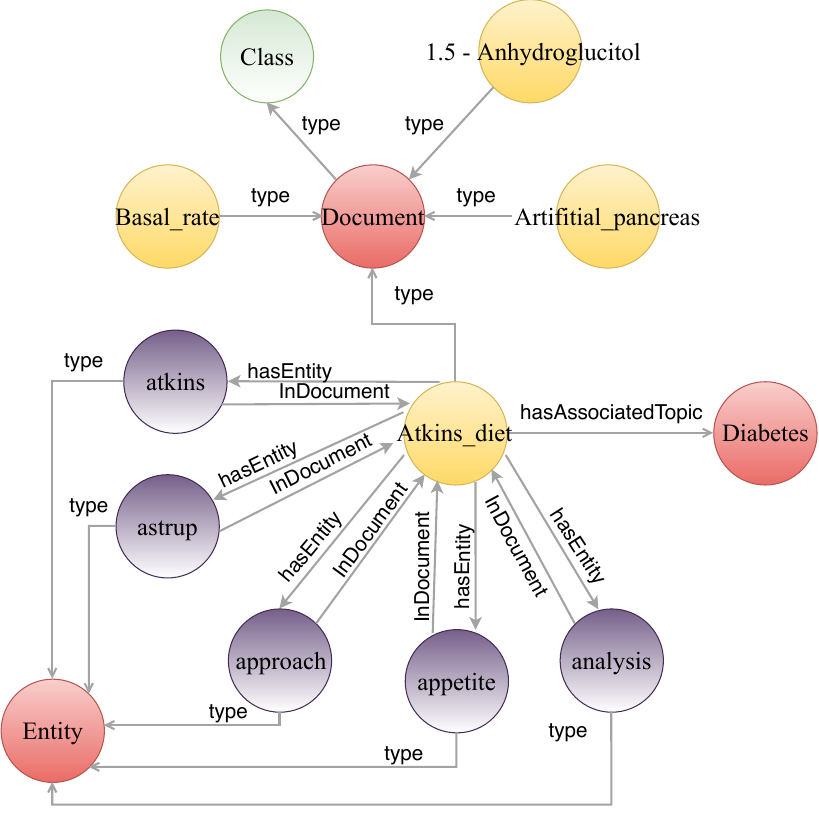
Figure 6. An excerpt of the diabetes